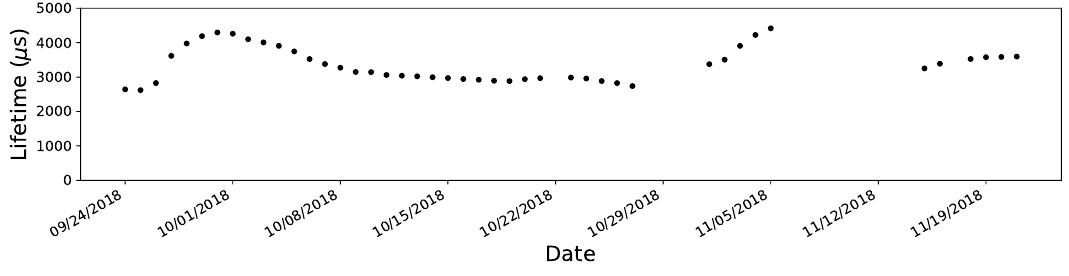
Figure 2 . The average electron lifetime over the course of the analyzed runs determined using 83 m Kr events. The errors on the measurements are smaller than the size of the points. Though consistently above 2 ms, the electron lifetime was unstable and therefore was monitored and the corresponding corrections determined for each run.